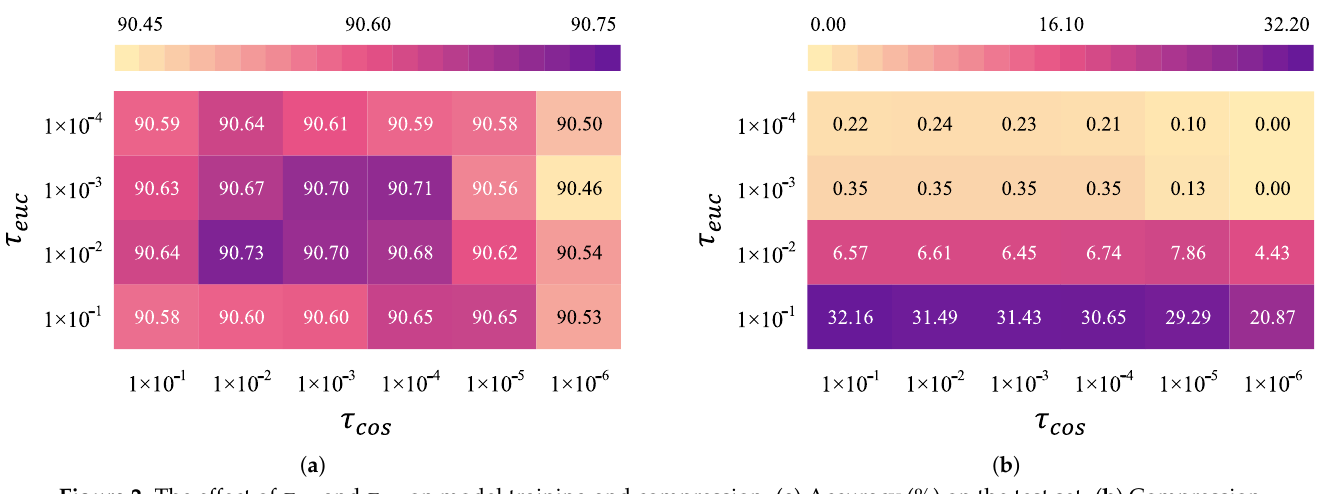
Figure 2. The effect of τ cos and τ euc on model training and compression. ( a ) Accuracy (%) on the test set. ( b ) Compression rate (%) at the end of the training